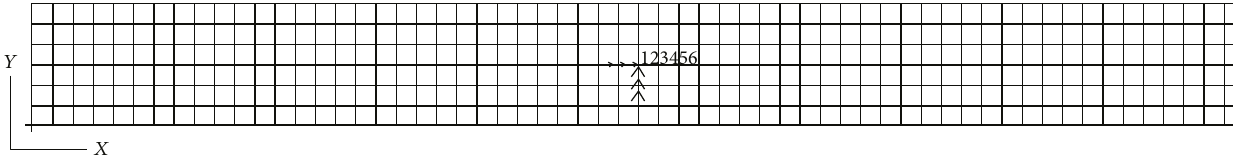
Figure 3: Finite element model of the laminates for hygrothermal e ff ect veri fi cation. B D F 0 S laminates on thermal